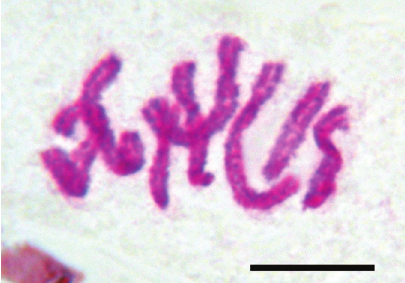
Figure 2. Crocus biflorus var. estriatus : metaphasic plate with 2 n = 2 x = 8 chromosomes. Scale bar: 10 μm.